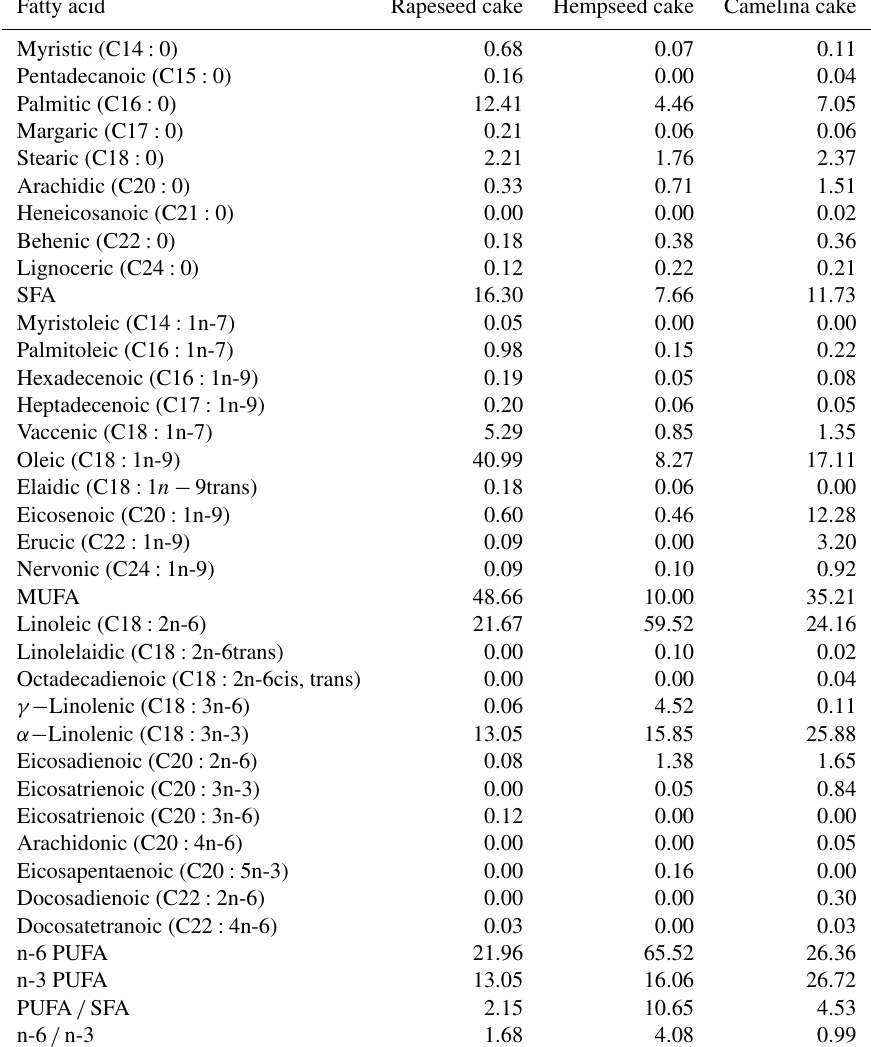
Table 2. Composition of fatty acid content of rapeseed, hempseed and Camelina cakes (% of total fatty acids). Fatty acid Rapeseed cake Hempseed cake Camelina cake Myristic (C14 :